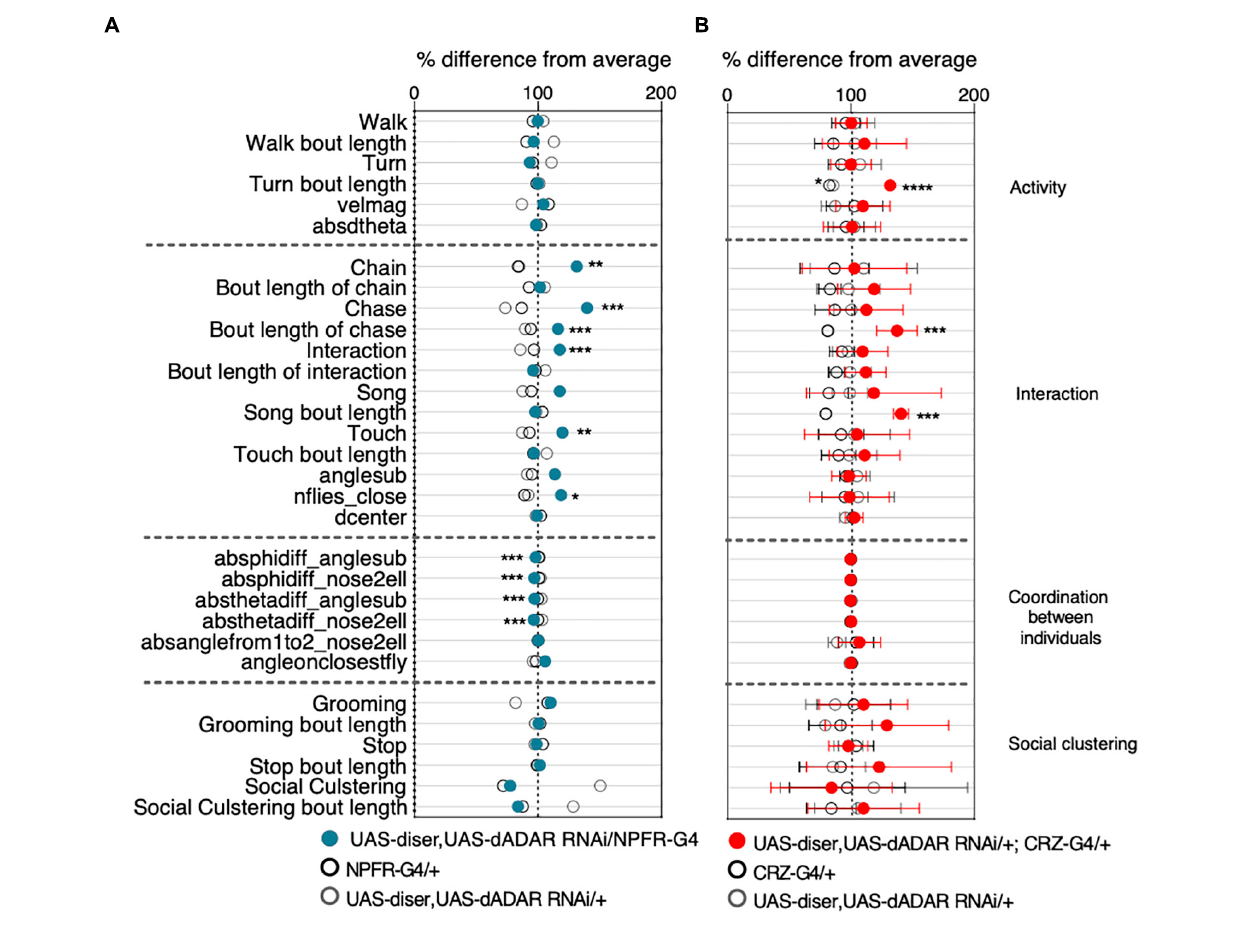
FIGURE 5 | RNA editing is required in NPFR neurons for typical male social behavior. Behavioral signatures of social group interaction. Data is presented as normalized scatter plots depicting% difference from average of 31 behavioral features. (A) Behavior profile of male flies harboring NPFR-Gal4/UAS-Dicer, UAS-dADAR RNAi (Blue) compared to genetic controls (UAS-Dicer, UAS-dADAR RNAi/ +, and NPFR-Gal4/ +, gray and black, respectively). n = 17. (B) Behavior profile of male flies harboring UAS-Dicer, UAS-dADAR RNAi/ +; CRZ-Gal4/ + (red) compared to genetic controls (UAS-Dicer, UAS-dADAR RNAi/ +, CRZ-Gal4/ +, gray and black, respectively). n = 7. One-way ANOVA with Tukey’s post hoc for normally distributed parameters and Kruskal-Wallis with Dunn’s test post hoc for non-normally distributed parameters. FDR correction was performed for all features. * P < 0.05, ** P < 0.01, *** P < 0.001, **** P < 0.0001, n . s . P >